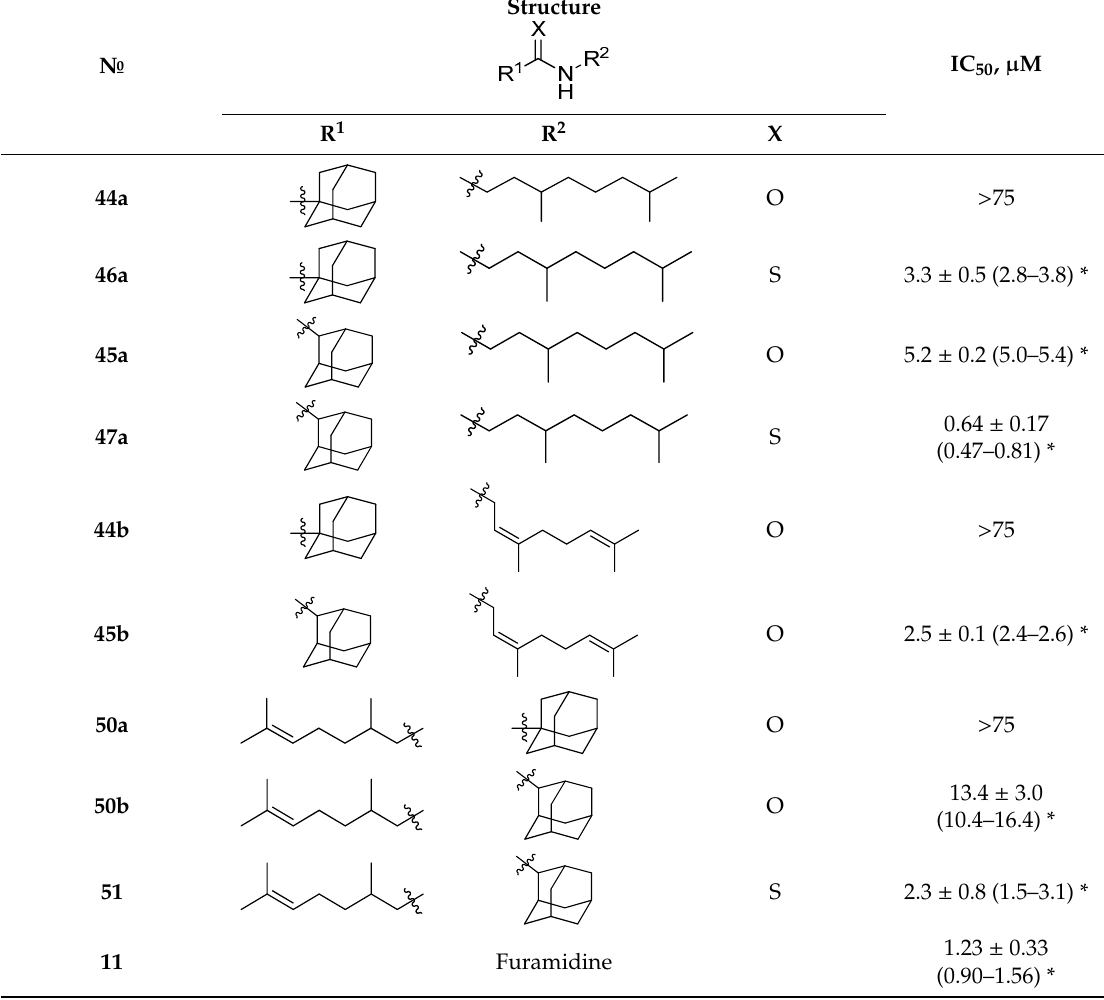
Table 1. Tdp1 inhibition potency of the adamantine derivatives.